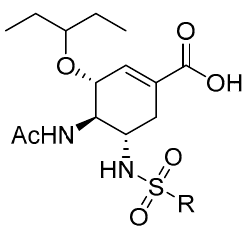
Figure 3. The general structure of designed compounds.